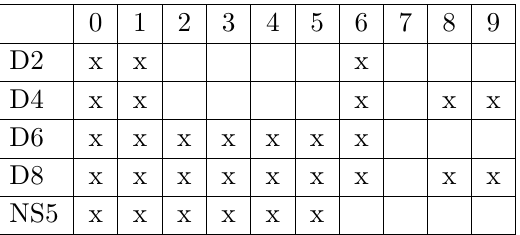
Table 3 . Distribution of branes compatible with the quantised charges of the NATD solution. ( y 0 ; y 1 ) are the directions where the 2d CFT lives, ( y 2 ; : : : ; y 5 ) parameterise the CY 2 , y 6 = (cid:26) , y 7 is the radius of AdS 3 and ( y 8 ; y 9 ) span the S 2